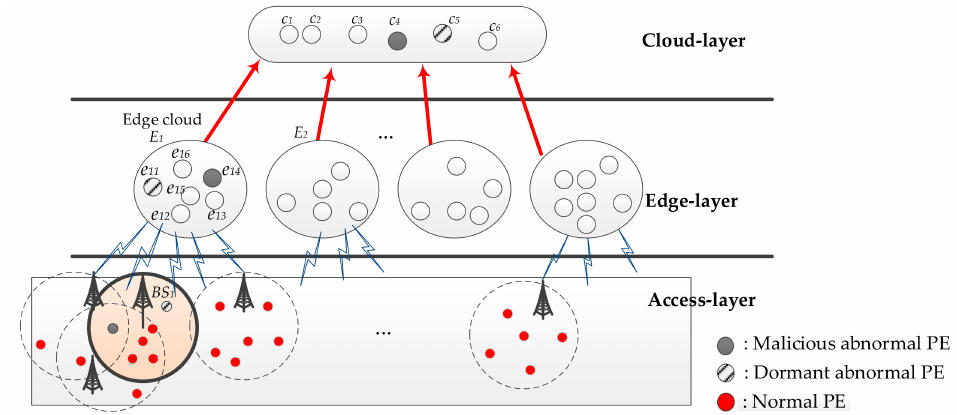
Figure 6. The example environment constructed by